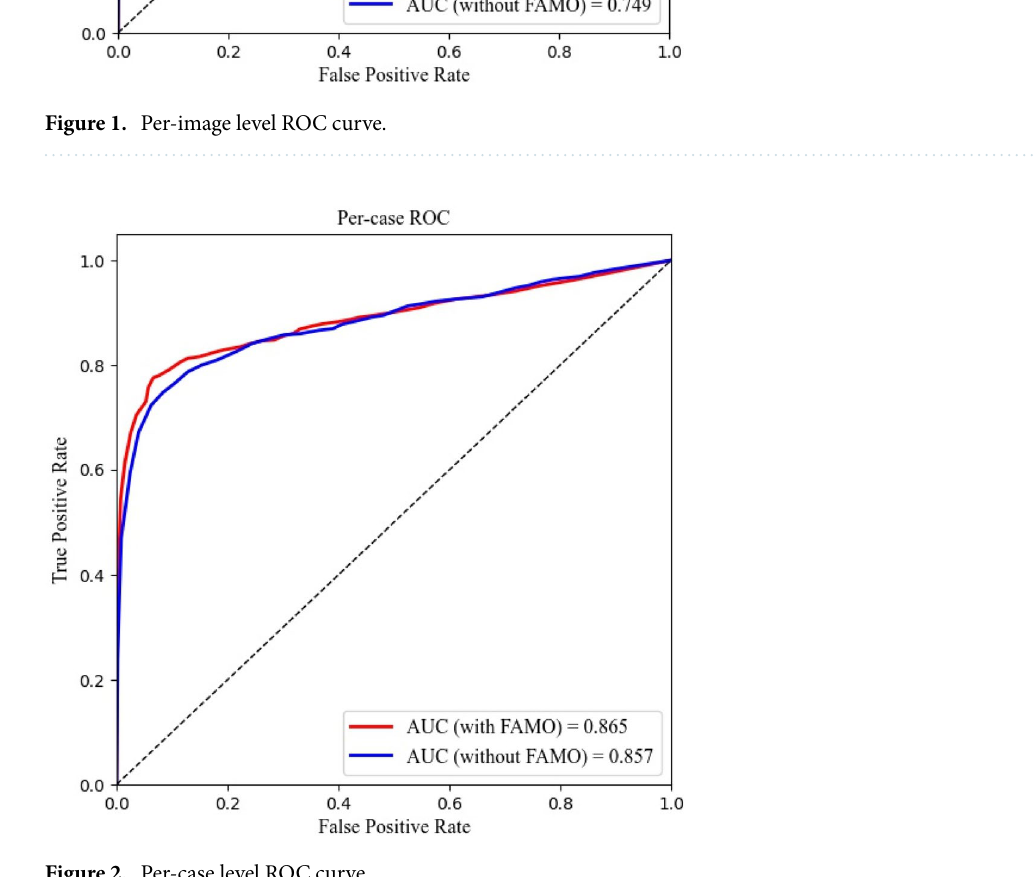
Figure 2. Per-case level ROC